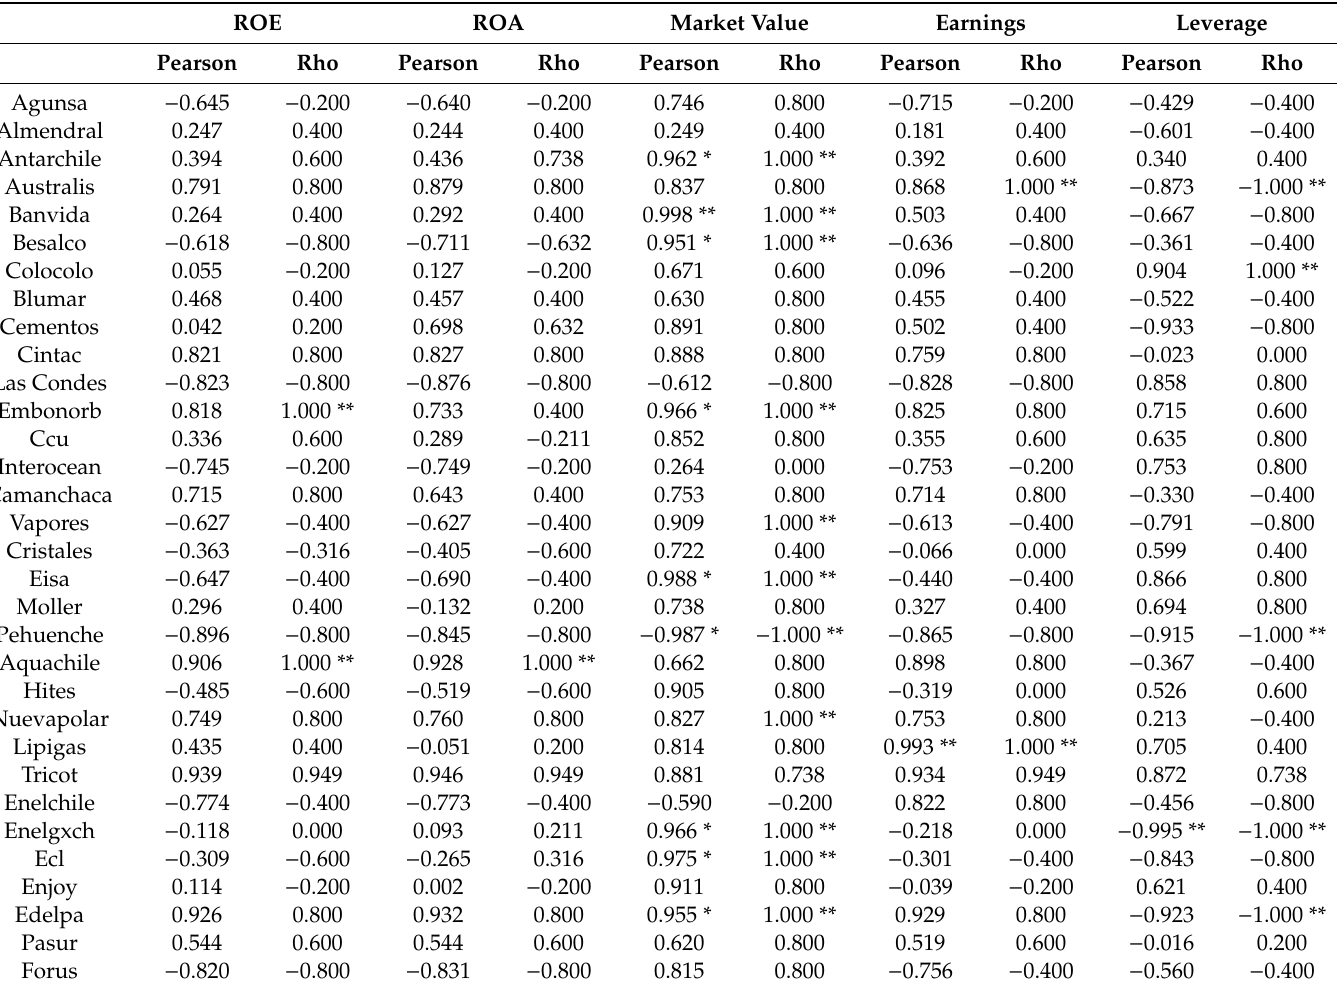
Table A2. Correlation of company variables with the